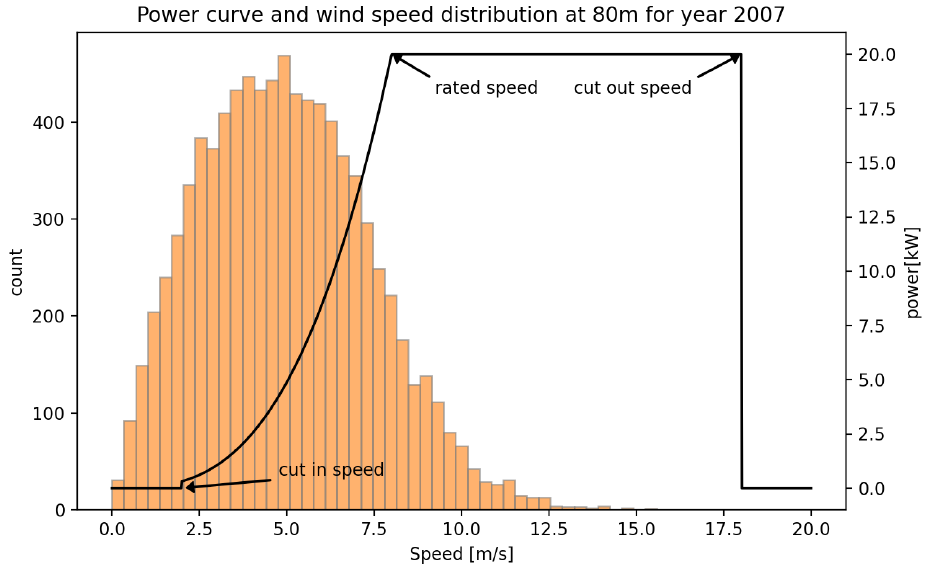
Figure 4. Power curve and the frequency distribution for the year 2007. With the wind capacity C wind fixed, C wind is the effective number of turbines, and the Pr corresponding total energy is given